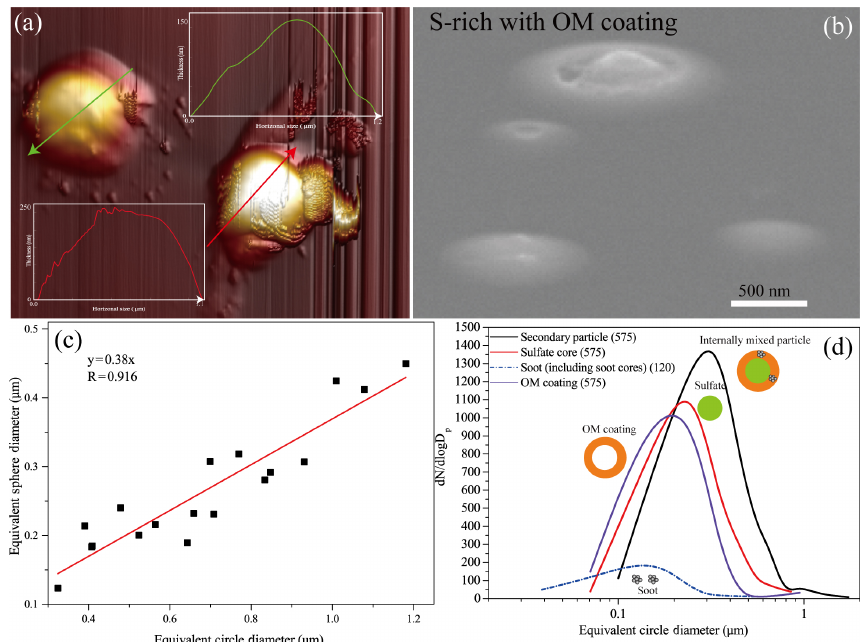
Figure 7. AFM image and calculated diameter of individual particles. (a) 3-D AFM image of sulfate-containing particles. The colored arrows represent the cross sections where the particle heights are measured (see inset figures). (b) SEM image of S-rich particles with OM coating obtained from 75 ◦ tilt of the SEM specimen stage. (c) The near-linear relationships between ECD and ESD based on S-rich particles with OM coating by atomic force microscopy. (d) Size distribution of individual particle with OM coating and sulfate core based on the estimated ESD diameter from TEM